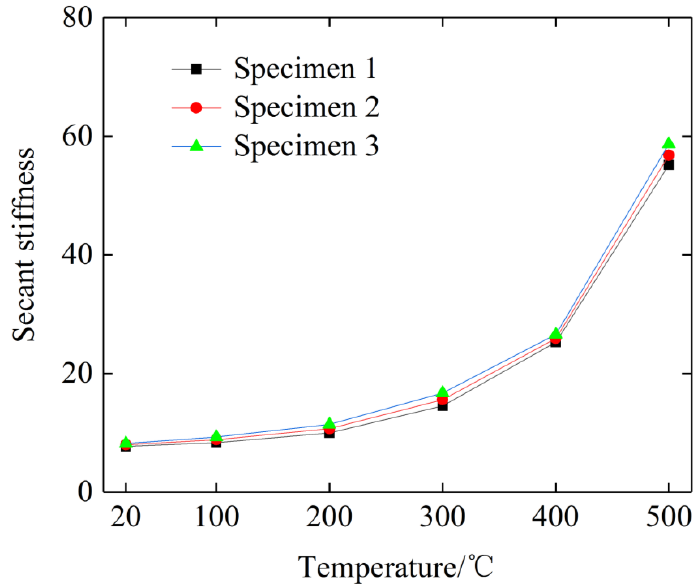
Figure 9. The trend of secant stiffness with temperature.